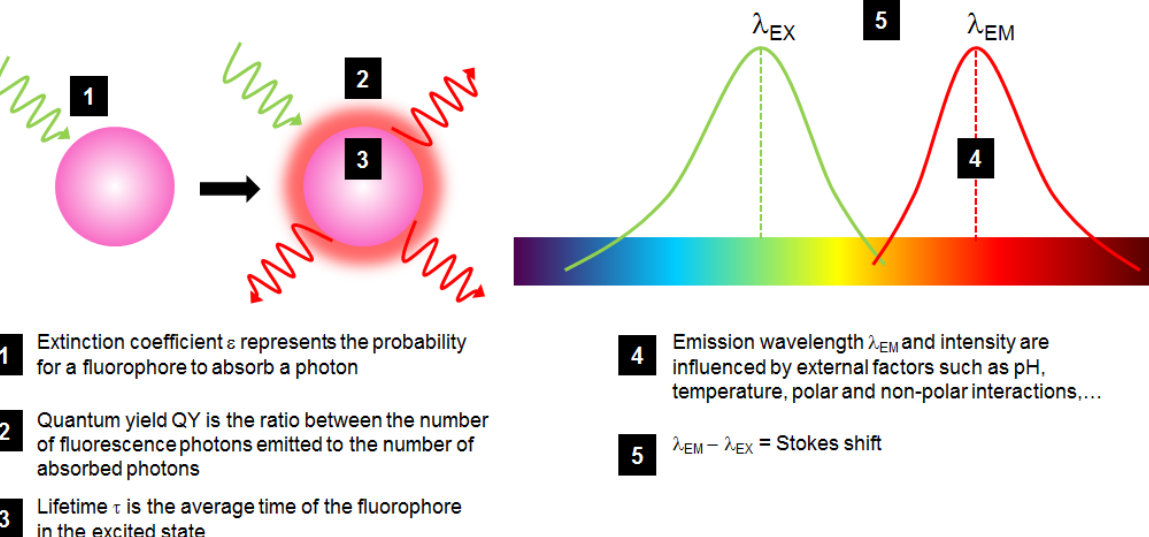
Figure 2. Schematic representation of the fluorescence phenomenon and of the most critical properties of a fluorophore (in pink) excited by a green light and fluorescing red